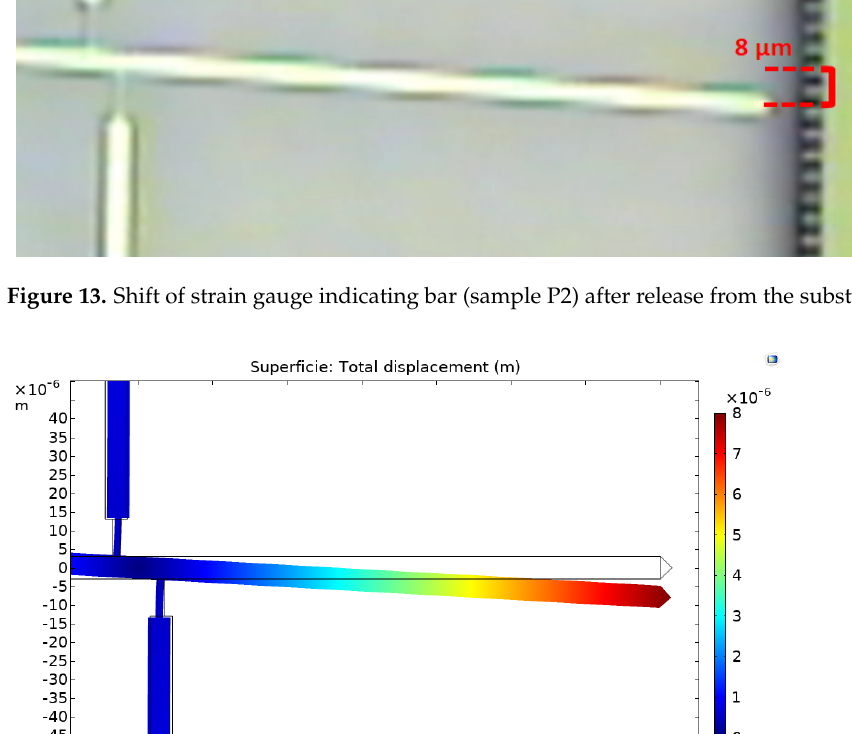
Figure 14. Simulated shift of strain gauge (P2 sample). In this case, Young’s modulus and the residual stress determined are 379 GPa and 360 MPa, respectively. Table 3. Overview of residual stress and Young’s modulus measurements on all the samples.